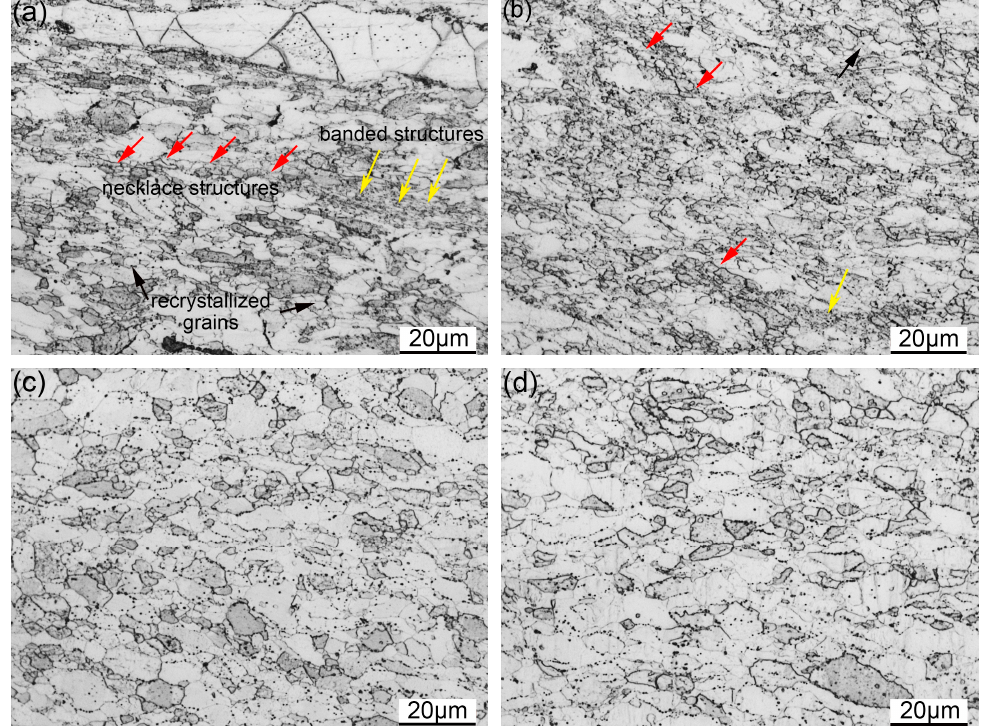
Figure 8. OM images of the samples deformed at 1200 °C with the strain rate of ( a ) 1 s − 1 ; ( b ) 0.1 s − 1 ; ( c ) 0.01 s − 1 ; ( d ) 0.001 s − 1 . ( c ) 0.01 s − 1 ; ( d ) 0.001 s − 1